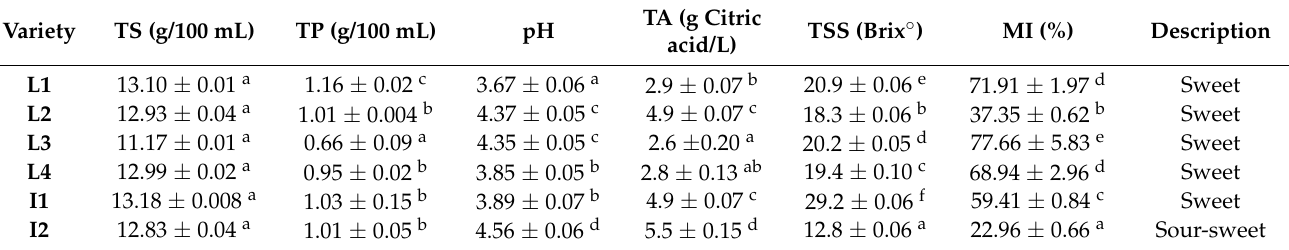
Table 4. Mean values of some chemical characteristics of PJ